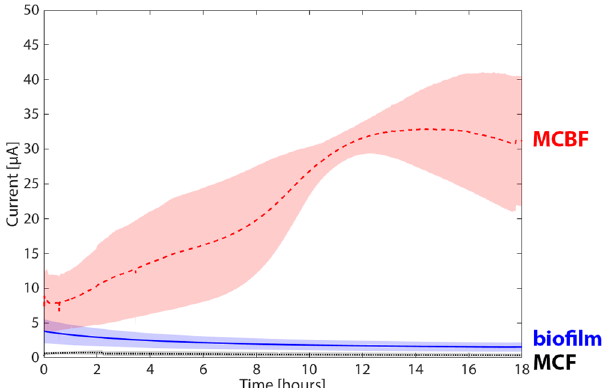
Figure 6. MCBF bioreactors produce greater biotic current than those using a native biofilm on unmodified CF. Chronoamperometric characterization of MESs based on MCBF (red dashed line) and UCF (blue solid line) using S. oneidensis metabolizing lactate, and abiotic MCF reactors (black dotted line). Light red, blue, and black colored bands indicate the standard deviation in current from three bioreactors,